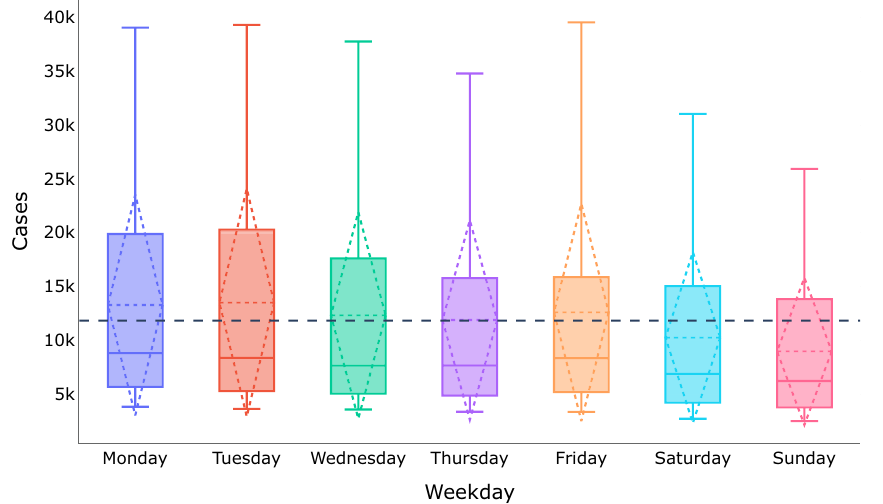
Figure 2. Statistics on the number of cases depending on the day of the week (ML train set). The dotted black line shows the mean of the daily cases in the study period, and in each boxplot the mean and standard deviation are also shown as dashed lines